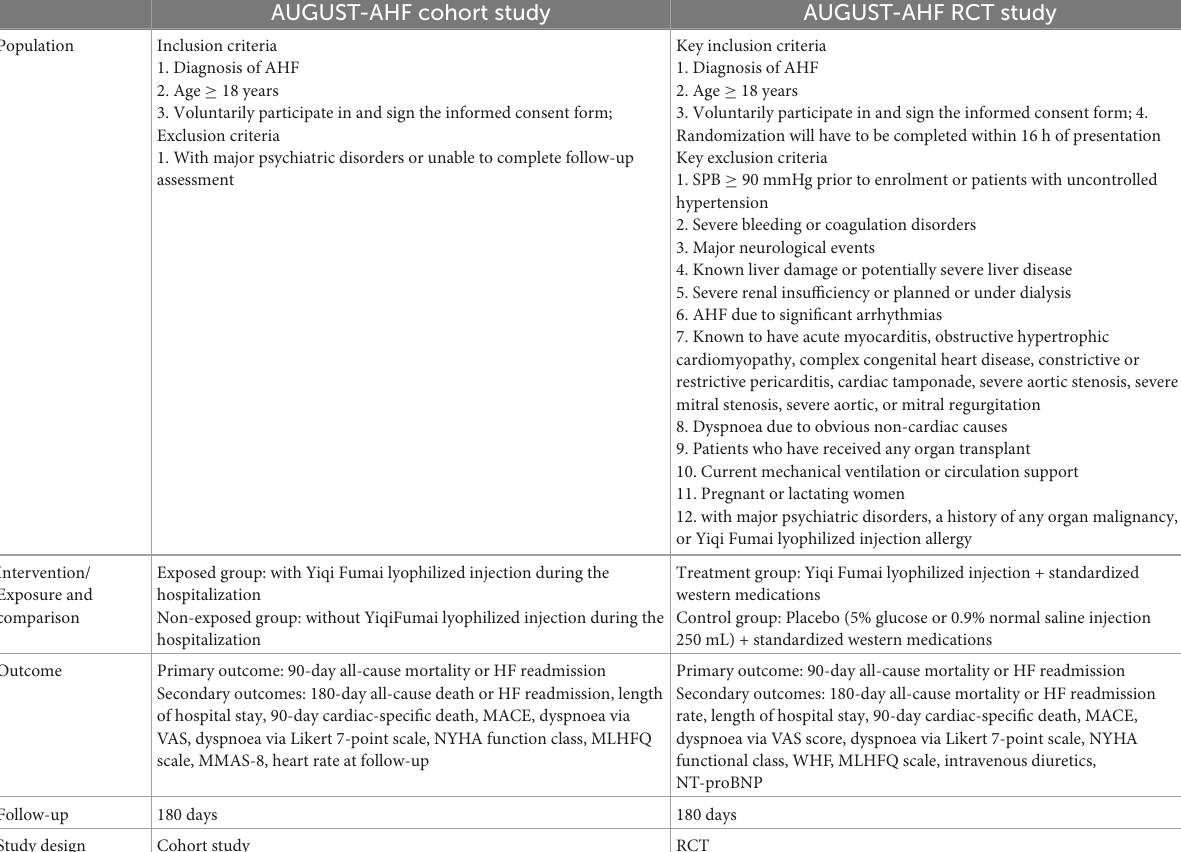
TABLE 1 Comparison of AUGUST-AHF cohort study and AUGUST-AHF RCT